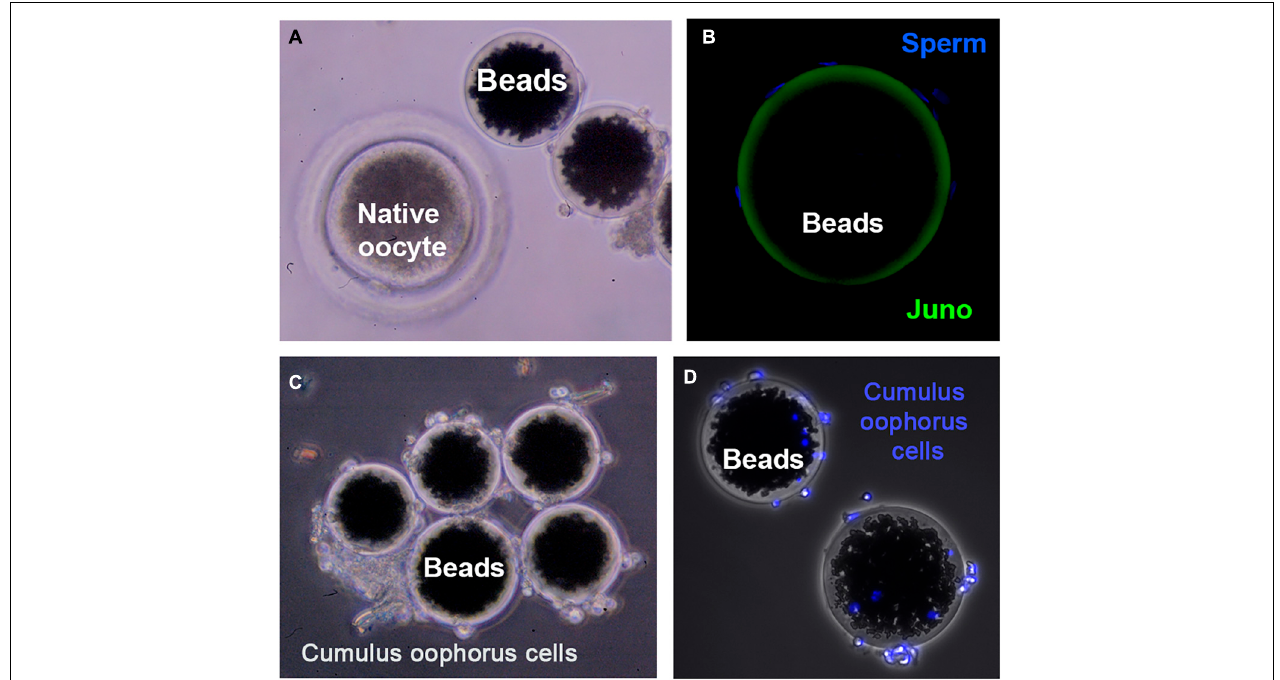
FIGURE 1 | Three-dimensional (3D) model for studying gamete interaction. (A) Protein-coated beads and native (porcine) denuded oocyte observed under a stereomicroscope. (B) Confocal microscopy images of beads conjugated to recombinant JUNO protein incubated with anti-FLAG antibody. Uniform coating of bead surface and sperm bound to the 3D model after a 2-h-period co-incubation with sperm observed. Sperm DNA is stained with Hoechst (blue). (C) 3D model enrichment by binding cumulus cells observed under stereomicroscope. (D) Fluorescence microscopy images showing cumulus cells stained with Hoechst (blue) tightly adhered to the protein-coated